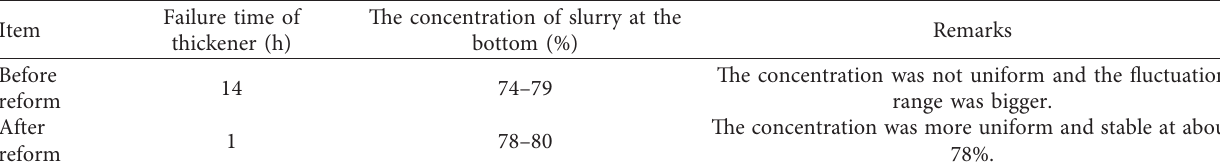
Table 1: Technical parameter statistics before and after the